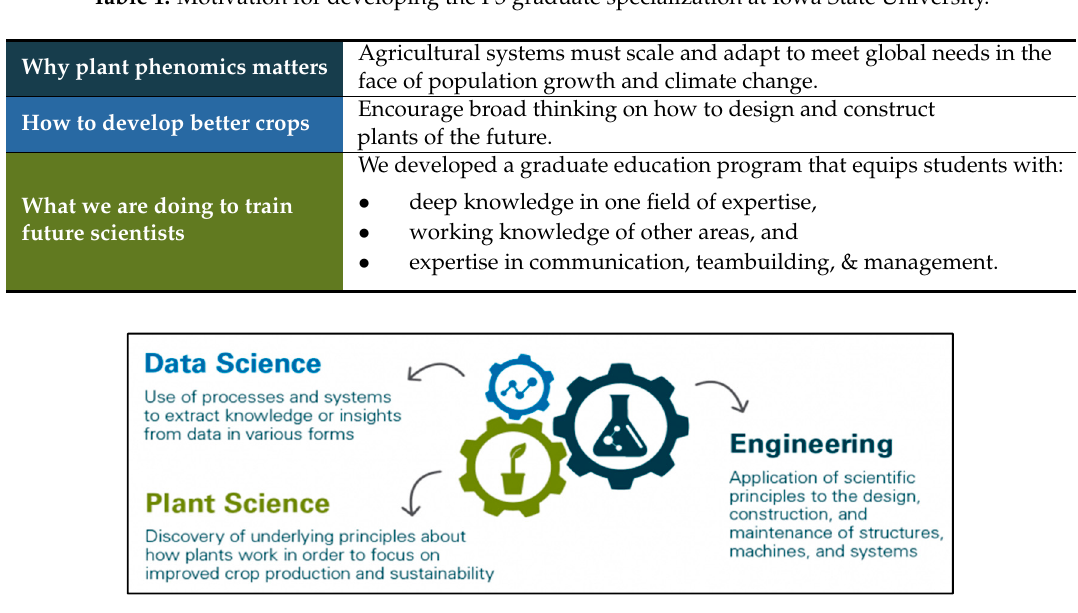
Figure 1. Disciplinary components necessary for predictive plant phenomics research. Researchers in the broad area of plant phenomics must be trained to work across at least three disciplines: Engineering, Plant Sciences, and Data Sciences. Each cog in the diagram represents an area of expertise. Arrows link each cog to a general description of the subject matter covered in a single discipline.